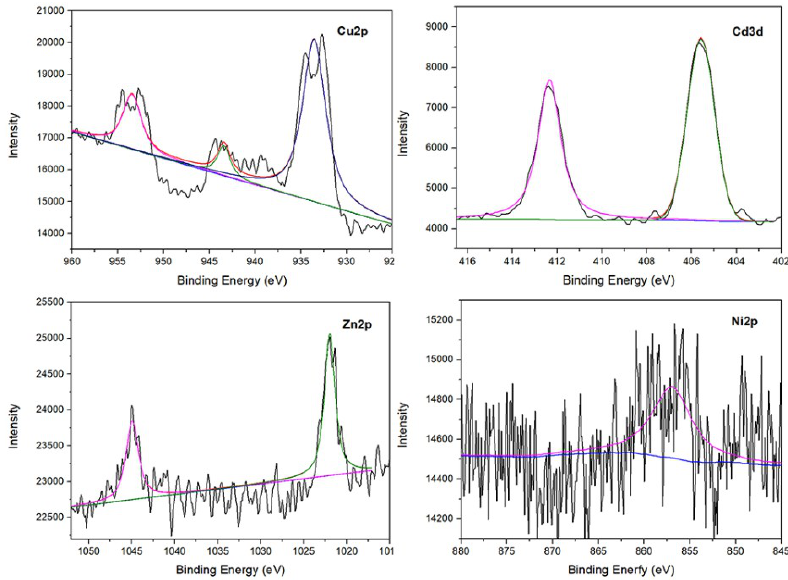
Figure 8. X-ray photoelectron spectroscopy (XPS) spectra of CA beads after the adsorption of mixed metal ions at a concentration of 500 mg / L in aqueous solution.